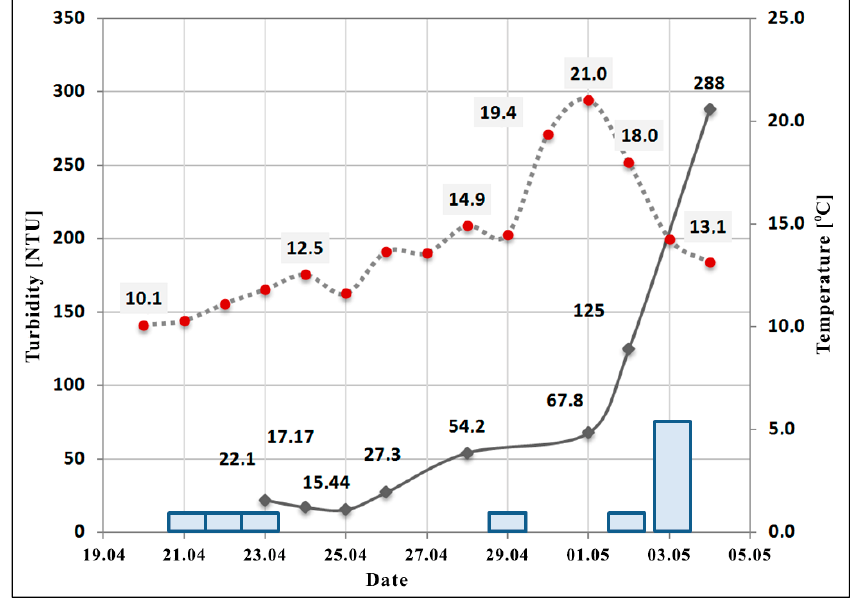
Figure 6. Changes in PT maximum turbidity (black line), daily average air temperature (dashed line) and precipitation (blue columns).